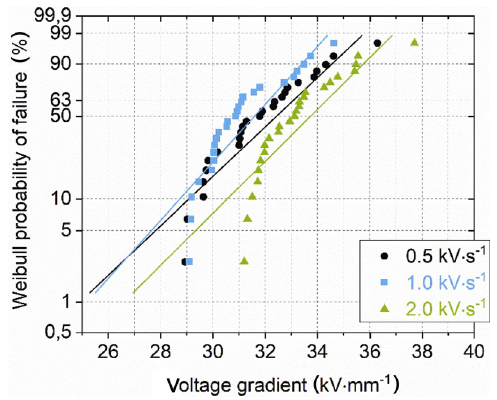
Fig. 2 Section of a channel formed by disruptive discharge in Al 2 O 3 (SEM, SE-detector).